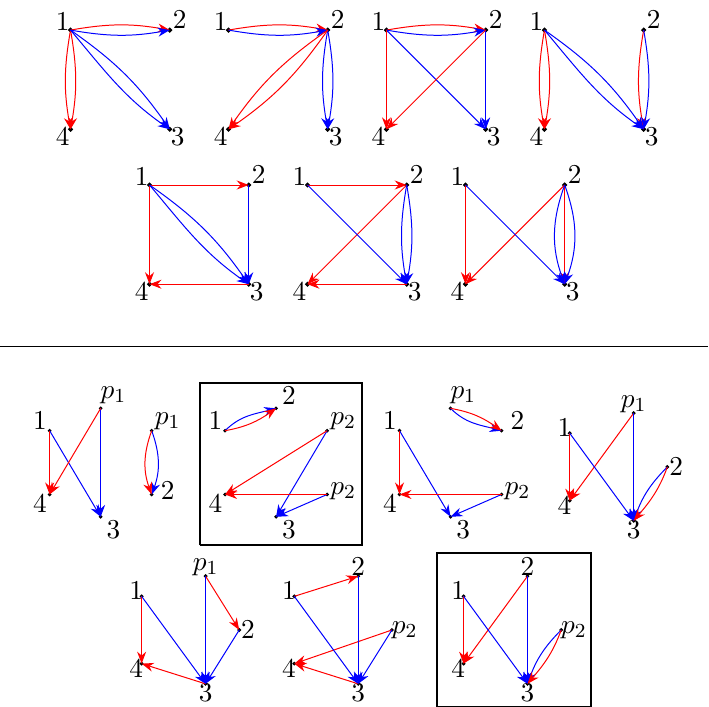
Figure 5 . We considered the planar graphs associated terms in the helicity category (1 1 0 , 2 1 0 , 3 +1 , 4 − 1 ) and mass dimension 6 . For simplicity, we did not consider a priori the ones with insertions of p and those proportional to any insertion of M 4 the unbolded and the bolded versions of the graphs to make the one-to-one correspondence evident. The two framed graphs correspond to our basis after taking into account momentum conservation.